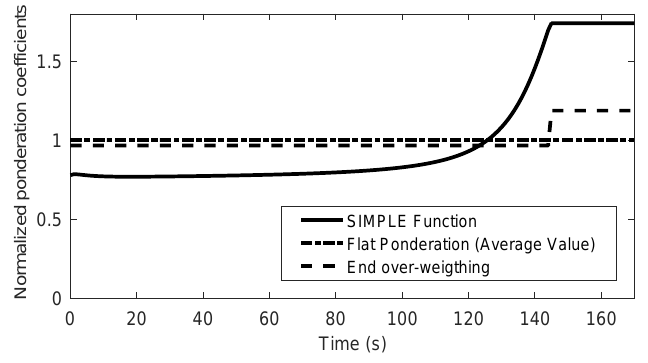
Figure 4. Normalized ponderation coefficients curves: SIMPLE ( c = 40, t = 0.55, s = 11), Flat, and end overweighting.